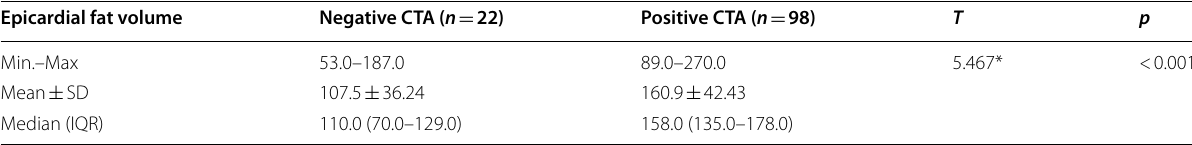
t: Student t-test; IQR: Interquartile range; SD: Standard deviation; p: p value for comparing between normal and abnormal *